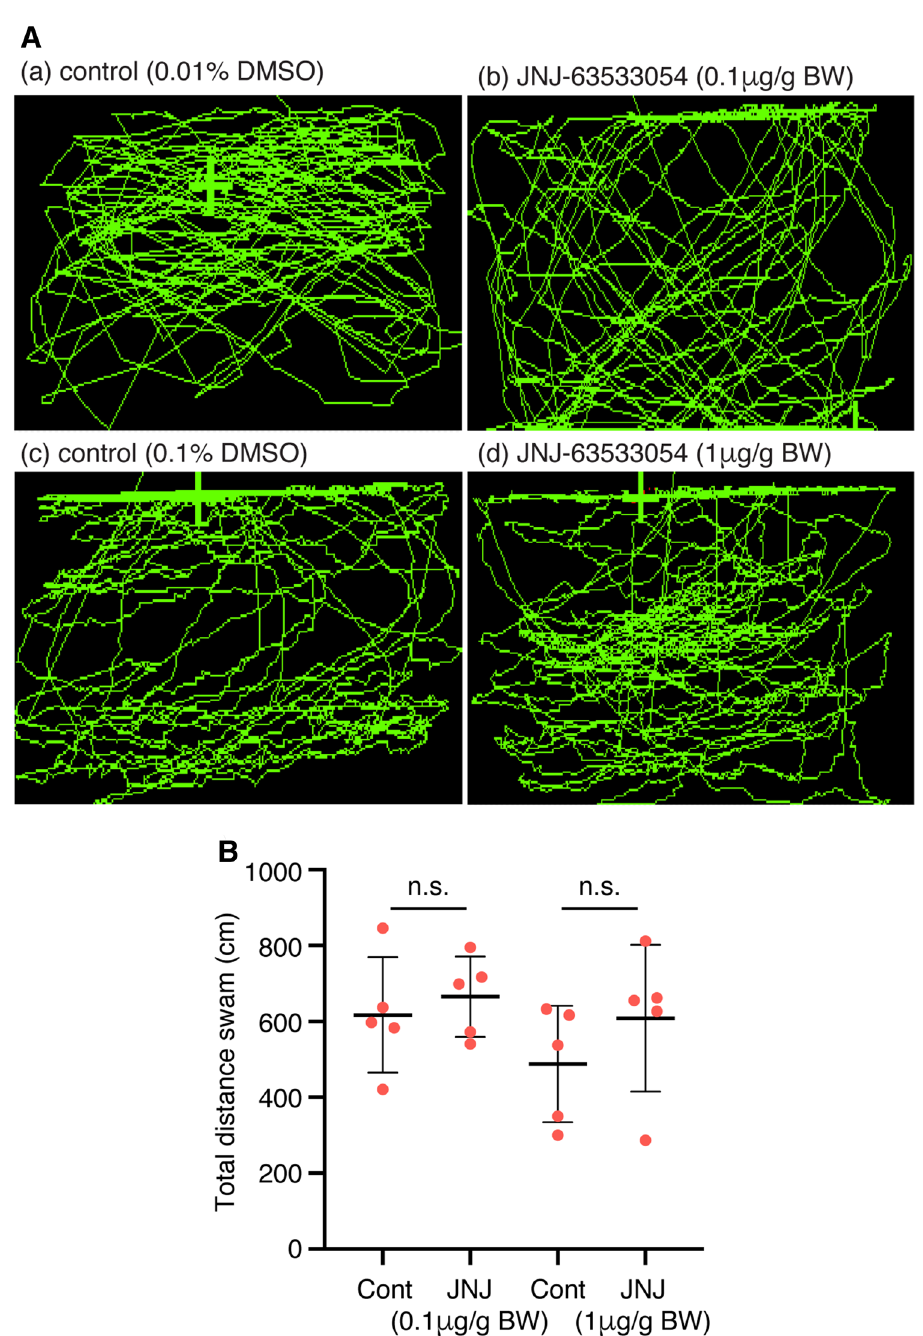
Figure 3. Effect of GPR139 agonist (JNJ63533054) on locomotion. ( A ) Side-view video tracking of swimming behaviour in the observation tank after administration of vehicle controls ( a , 0.01% DMSO; c , 0.1% DMSO) and GPR139 agonist ( b , 0.1 µg/g; d , 1 µg/g body weight, BW). ( B ) Effect of GPR139 agonist on locomotor activity was assessed by analysing total distance swam in the tank, but there was no significant (n.s.) effect of GPR139 agonist (0.1 µg/g, P = 0.5784; 1 µg/g, P = 0.3053) on locomotor